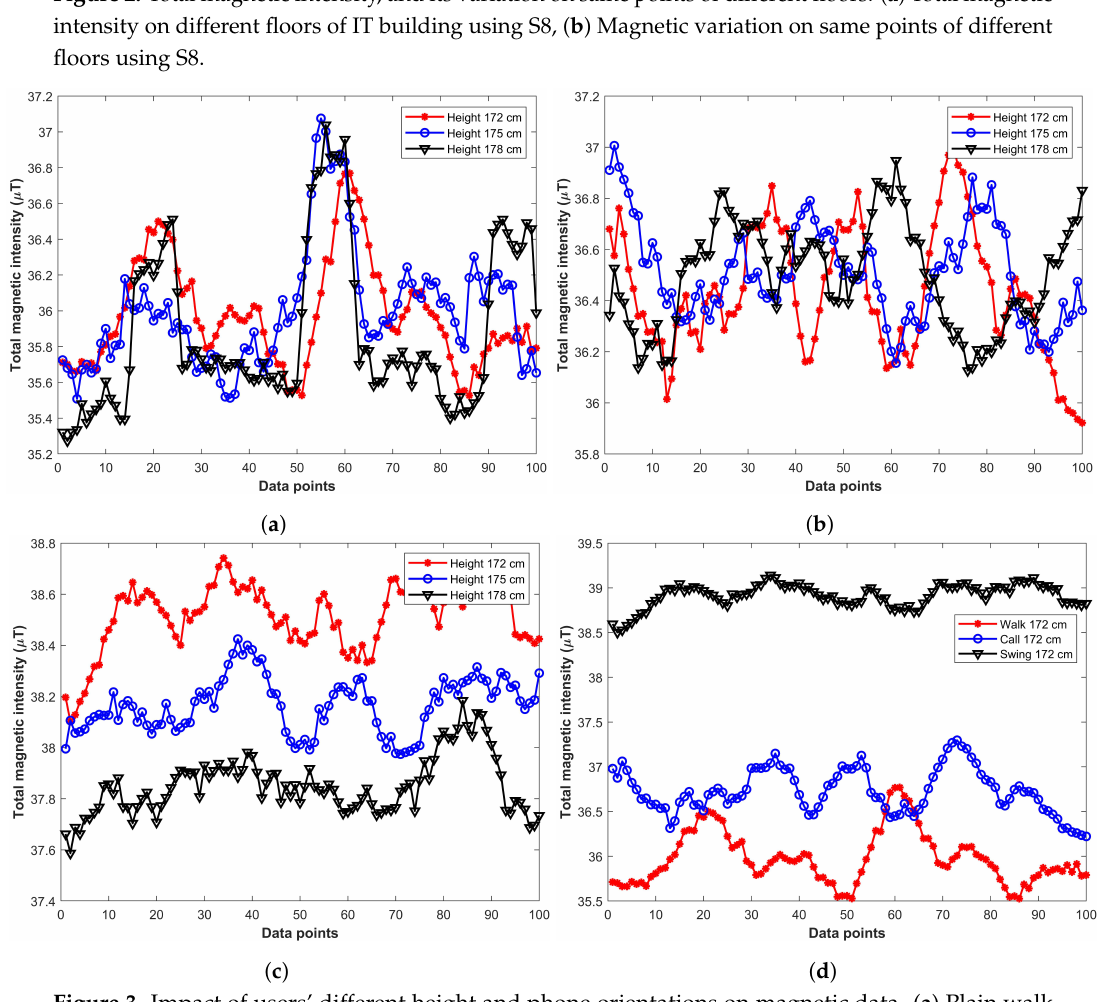
Figure 3. Impact of users’ different height and phone orientations on magnetic data. ( a ) Plain walk orientation with different heights, ( b ) Call listening orientation with different heights, ( c ) Phone swinging with different heights, ( d ) Same height different